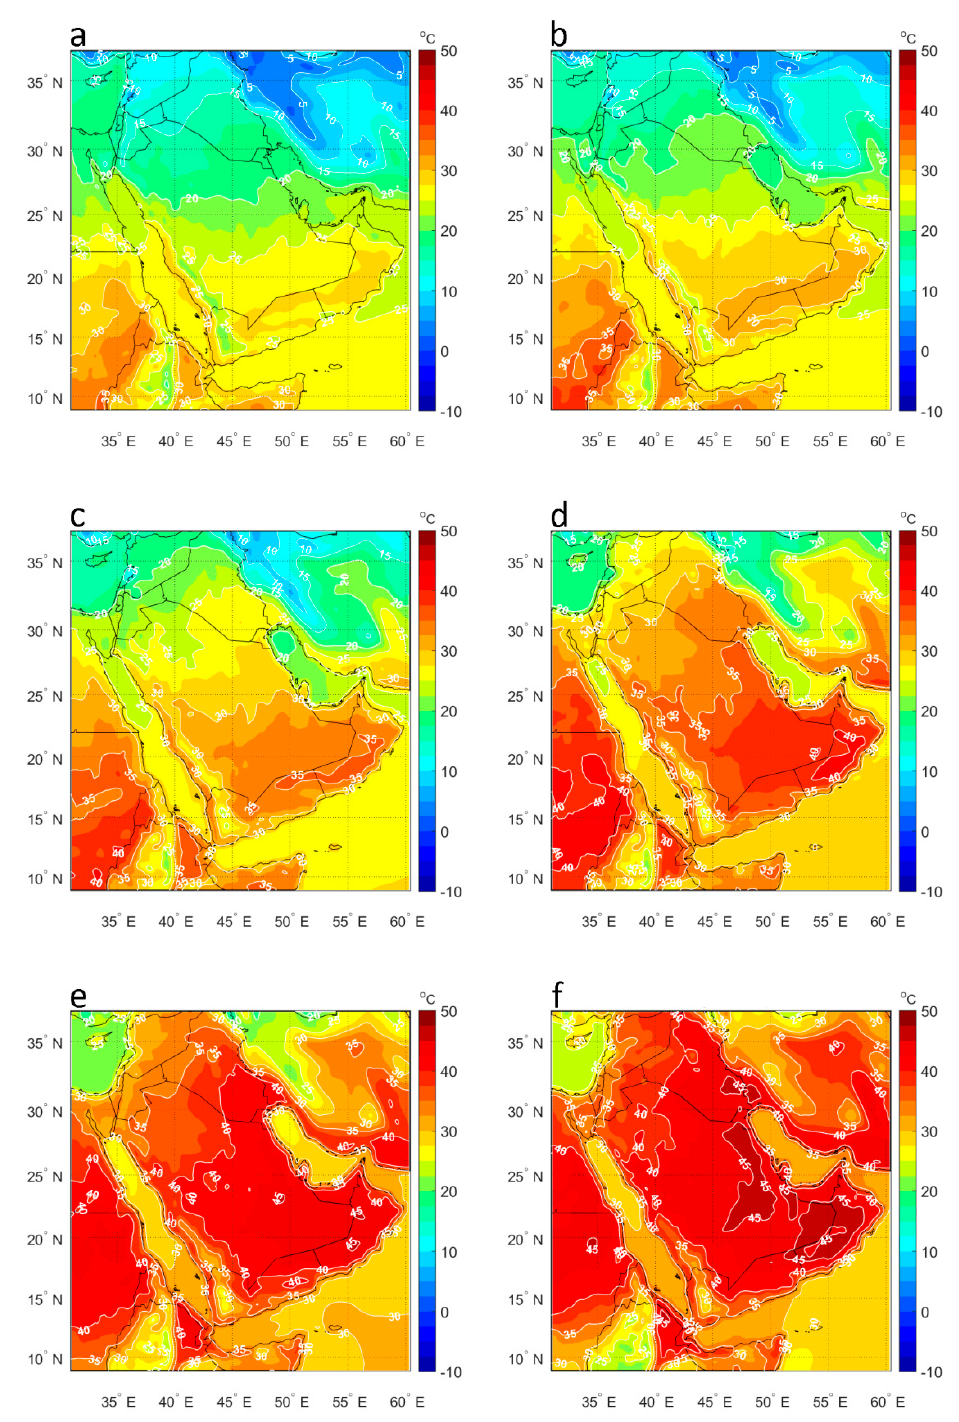
Figure A3. Mean values of daily maximum temperature for the months January to June ( a – f ).